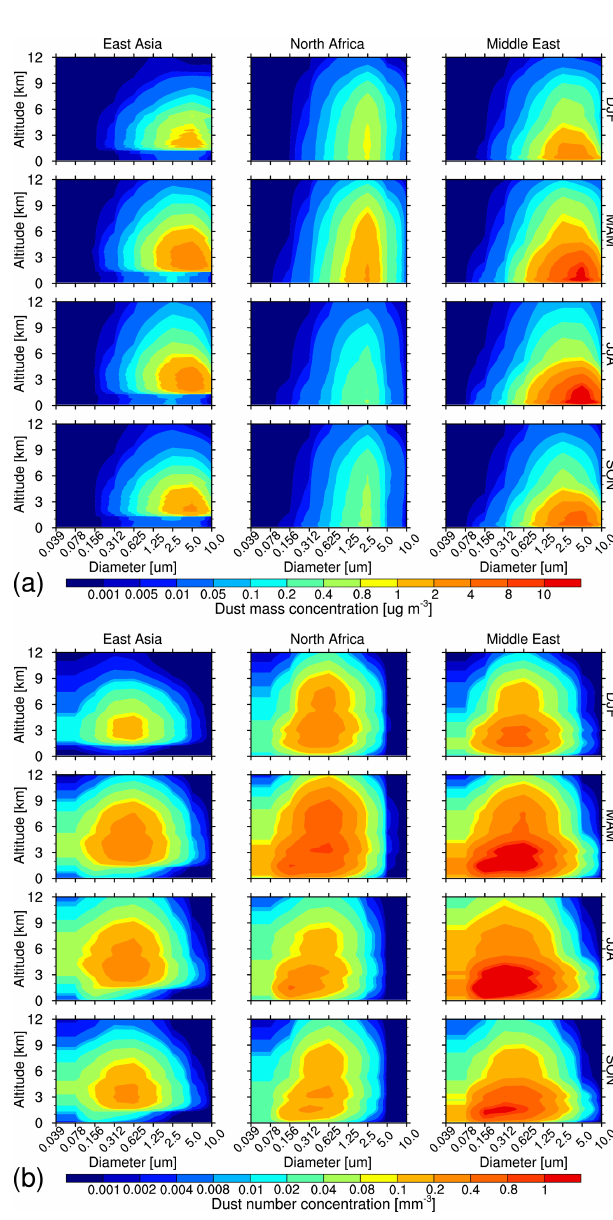
Figure 10. (a) Vertical distribution of seasonal dust mass concentra- tion (micrograms per cubic meter) over the TP within various parti- cle size groups emitted from East Asia, North Africa, and the Mid- dle East averaged for 2010–2015. (b) Vertical distribution of sea- sonal dust particle number concentration (per cubic meter) over the TP in different particle sizes emitted from East Asia, North Africa, and the Middle East averaged over the period of